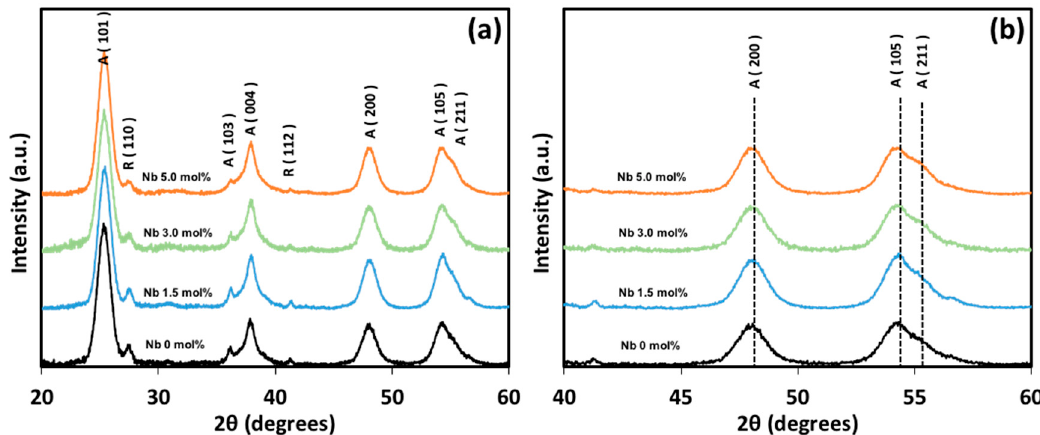
Figure 1. ( a ) X-ray diffraction (XRD) patterns of TiO 2 with varying Nb contents (A: Anatase, R: Rutile). ( b ) XRD patterns between 2 θ values of 40° and 60°.